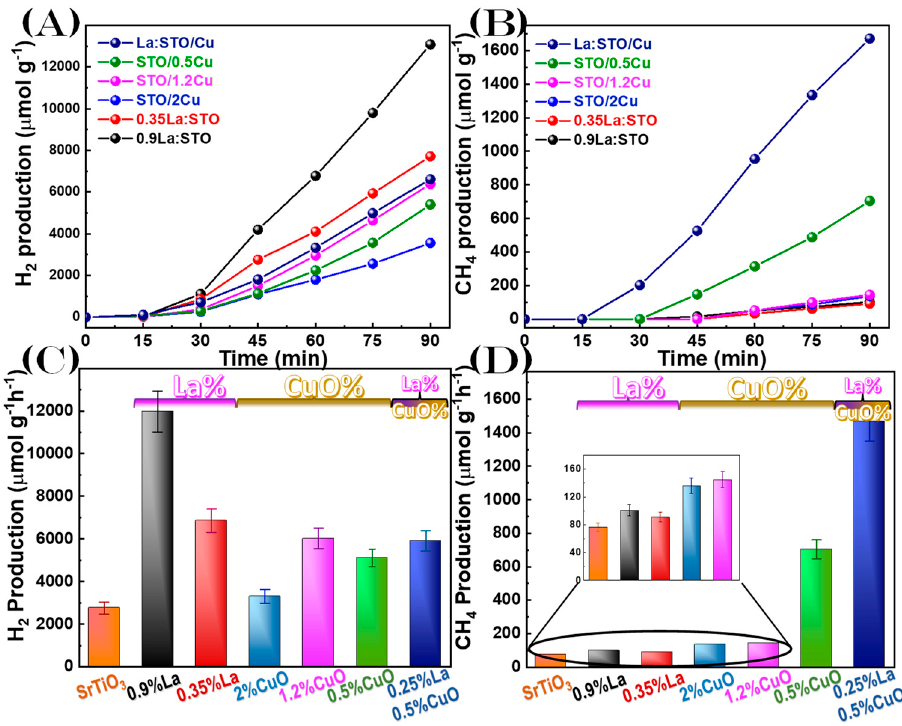
Figure 7. Photocatalytic production by the nanomaterials from an H 2 O/CH 3 OH mixture. ( A ) H 2 -gas vs. time. ( B ) CH 4 -gas vs. time. ( C , D ) the corresponding gas production rates (umol per gr catalyst per hour).